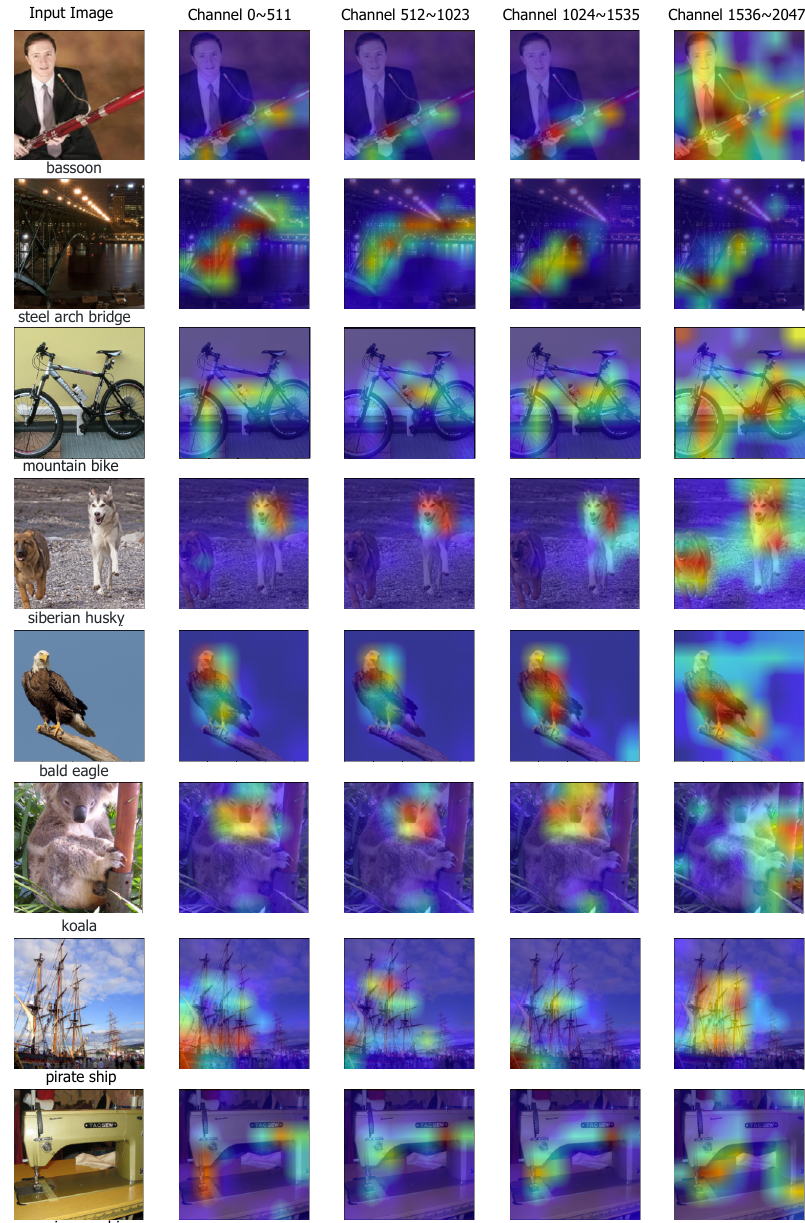
Figure 3. Additional Grad-CAM visualization